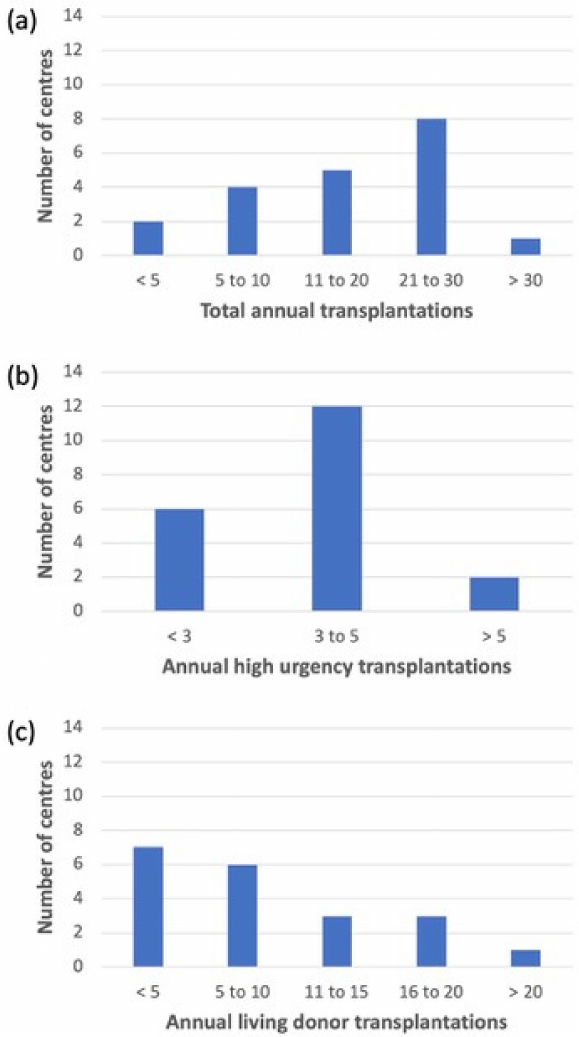
Figure 1. Annual frequency of paediatric liver transplantations in the participating centres. ( a ) Total number of annual transplantations. ( b ) Number of high urgency transplantations. ( c ) Living donor